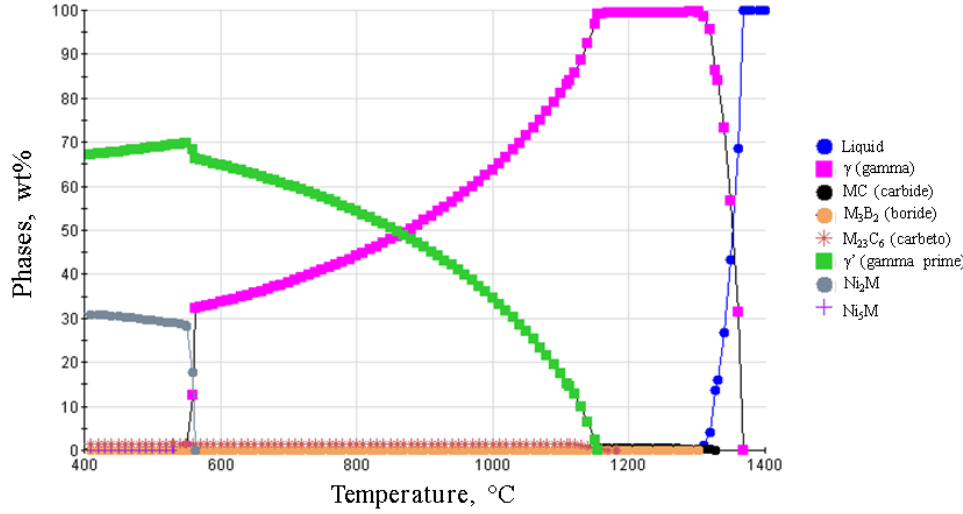
Figure 8. Percentage (in wt.%) of the majority phases vs temperature in Inconel 713C.